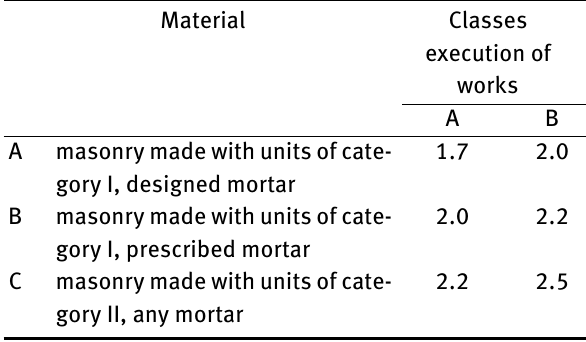
Table 1: The exemplary values of the partial factor 𝛾 m according to the polish annex EC6 [3]